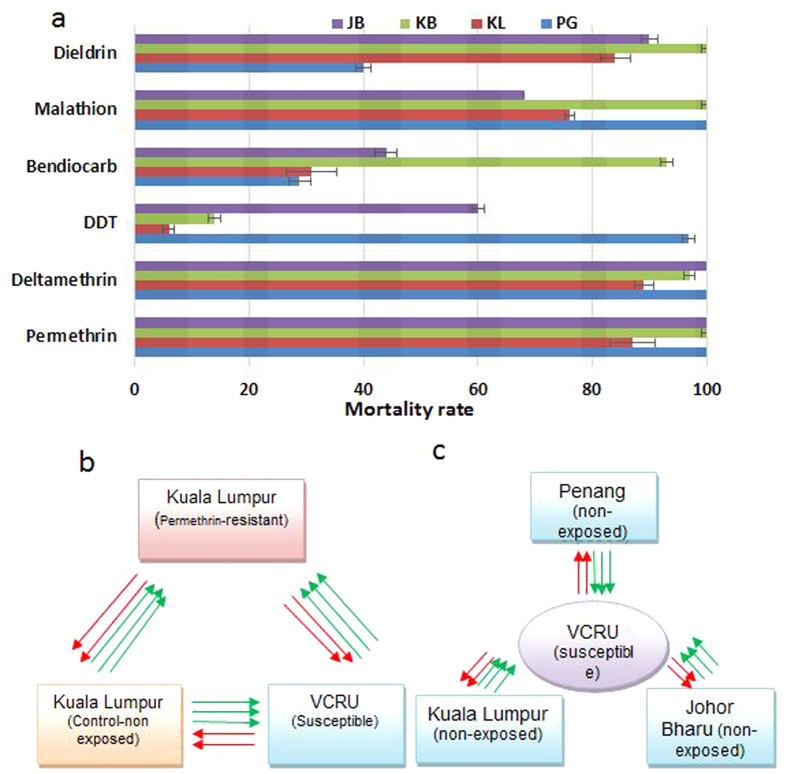
Insecticide resistance profile and experimental design of transcriptomic analyses.(a) Resistance profiles to different insecticide classes in female Ae. albopictus mosquitoes across Malaysia including KL (Kuala Lumpur), PG (Penang), JB (Johor Bharu) and KB (Kota Bharu). (b) Schematic representation of the experimental design of the microarray studies for the permethrin resistance profiling whereas (c) is for the comparison between non-exposed (control) vs susceptible samples across Malaysia. Green arrows refer to Cy3 dye, and red arrows refer to Cy5 dye.